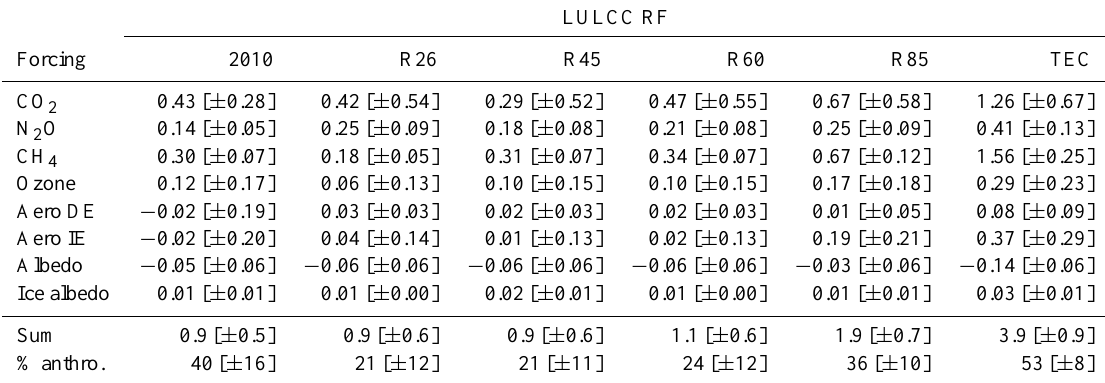
Table 2. LULCC RF values and uncertainties for year 2010 and all future scenarios (year 2100) relative to the year 1850. Sum RFs are the total of all forcing agents and have been rounded to the nearest 0.1Wm − 2 . The theoretical extreme case is abbreviated to “TEC”.